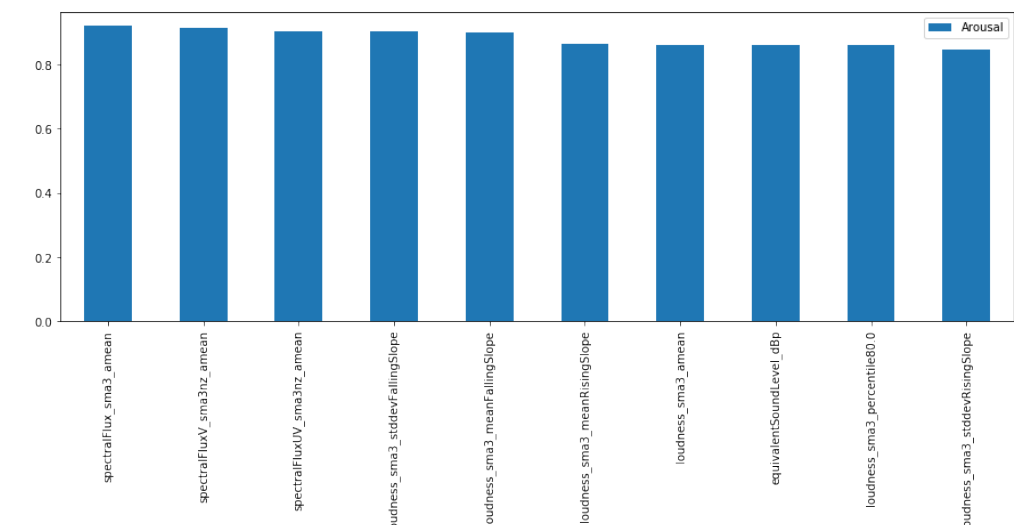
Figure 6. Emotional Variables Weights for Valence.